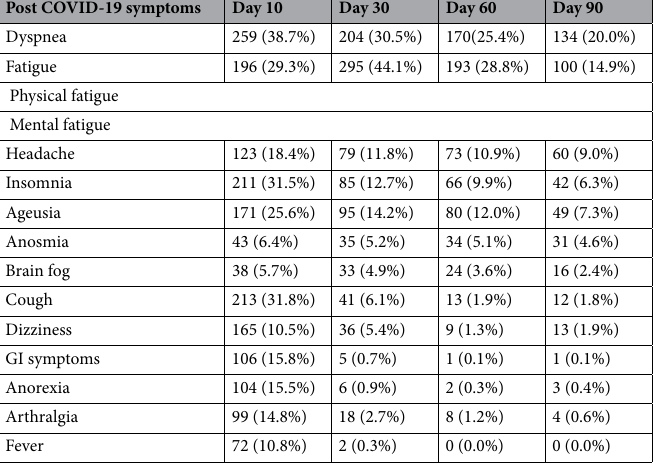
Table 3. Frequency of COVID-19 signs and symptoms at day 10, day 30, day 6, and day 90 (n =